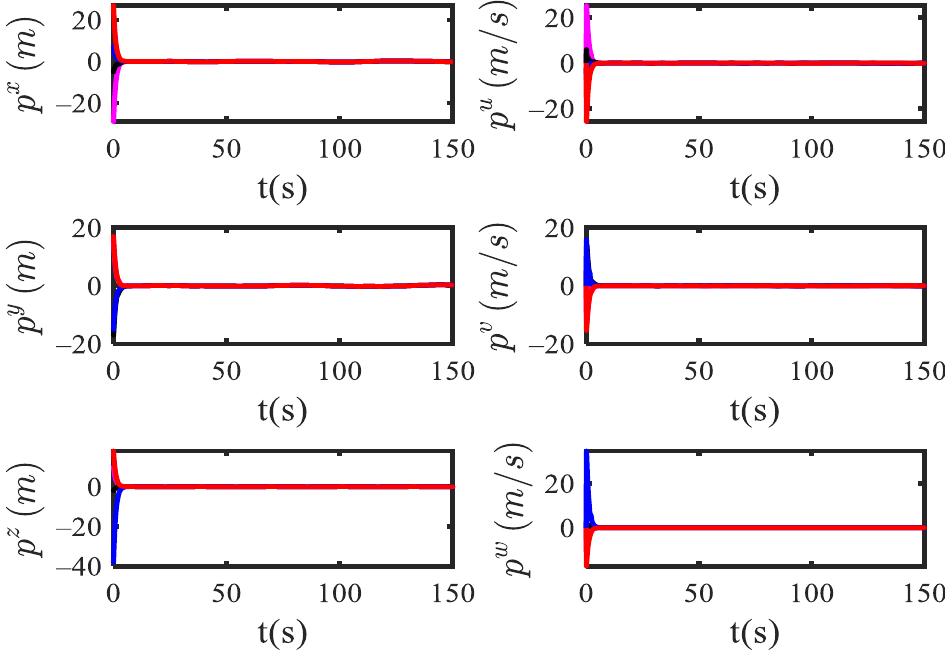
Figure 8. Position errors and velocity errors of UUVs.